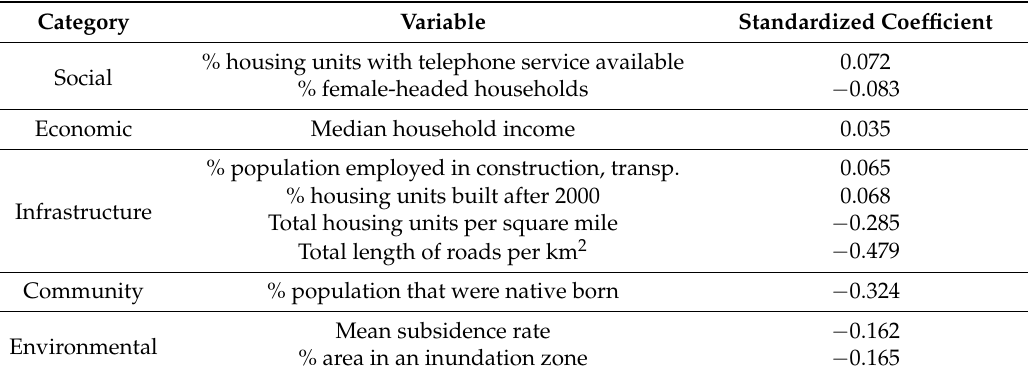
Table 1. Regression coefficients between the 10 variables selected from stepwise discriminant analysis and the resilience (RIM)